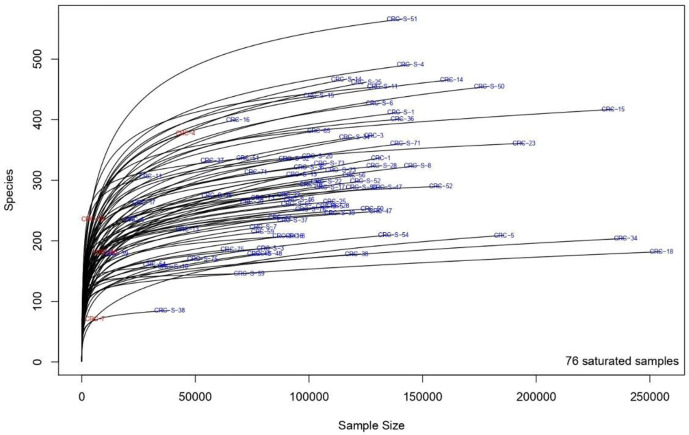
Rarefaction curves showing the level of saturation of OTUs.